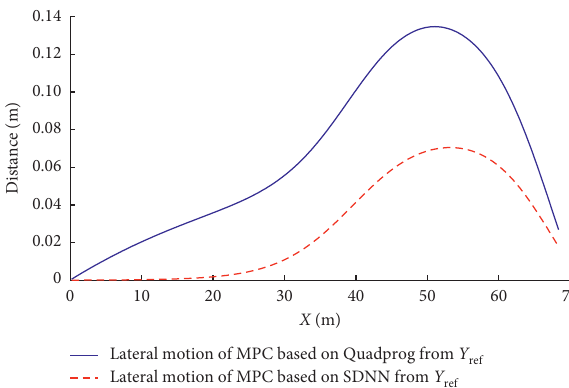
Figure 25: Lateral motion errors of two controllers.